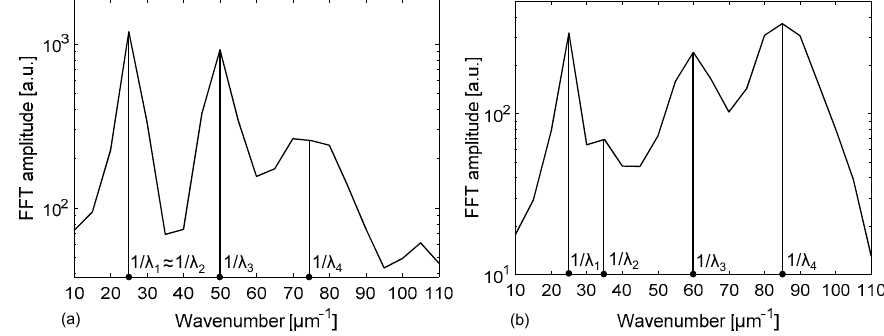
Figure 4. Results of the Fast Fourier Transform applied to the calculated spectral reflectivity reported in Figure 2 for a rectangular – miniature hollow glass tubing with d = 30 µm, t f = t b = 21 µm (nominal dimensions): ( a ) empty channel; ( b ) channel filled with water.